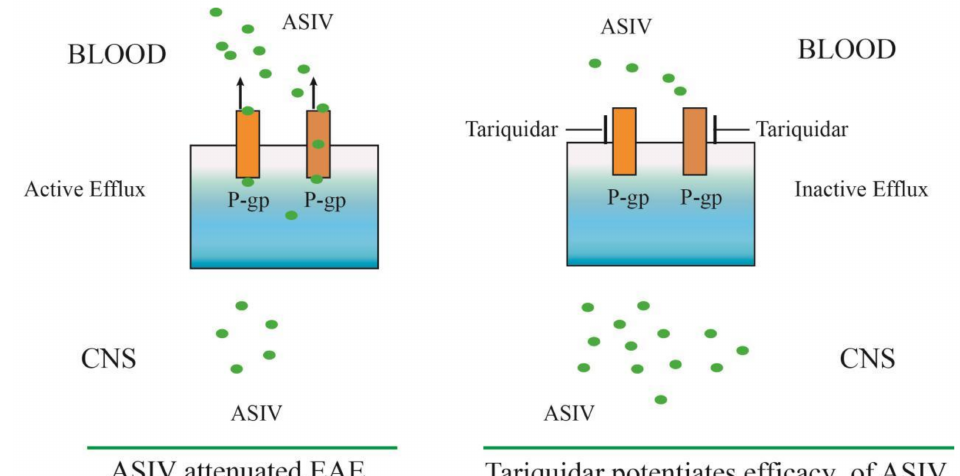
Figure 7. Schematic illustration of the effect and mechanism of tariquidar, a P-gp inhibitor, in potentiating the efficacy of ASIV on EAE. P-gp was significantly increased in microvascular endothelial cells from the cortex in EAE mice, which might compromise the efficacy of ASIV on EAE. Coadministration of tariquidar potentiated the neuroprotective effect of ASIV in EAE mice by reducing the efflux of the penetrated ASIV in the